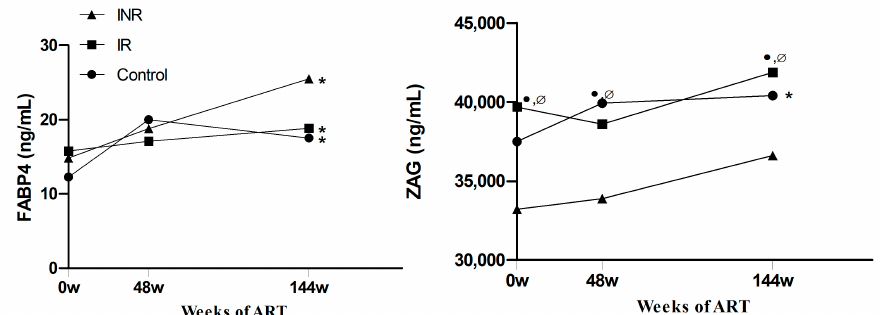
Figure 5. ART effect on circulating adipokine concentrations. Longitudinal study of circulating FABP4, ZAG, omentin, and resistin concentrations during ART follow-up. * indicates significant differences at 144 w compared to baseline values using the Wilcoxon test. • indicates significant differences compared to controls ( n = 120), (cid:78) indicates significant differences between controls and IR, and Ø indicates significant differences between INRs ( n = 22) and IRs ( n = 77) at each point of time, by nonparametric Mann–Whitney test.